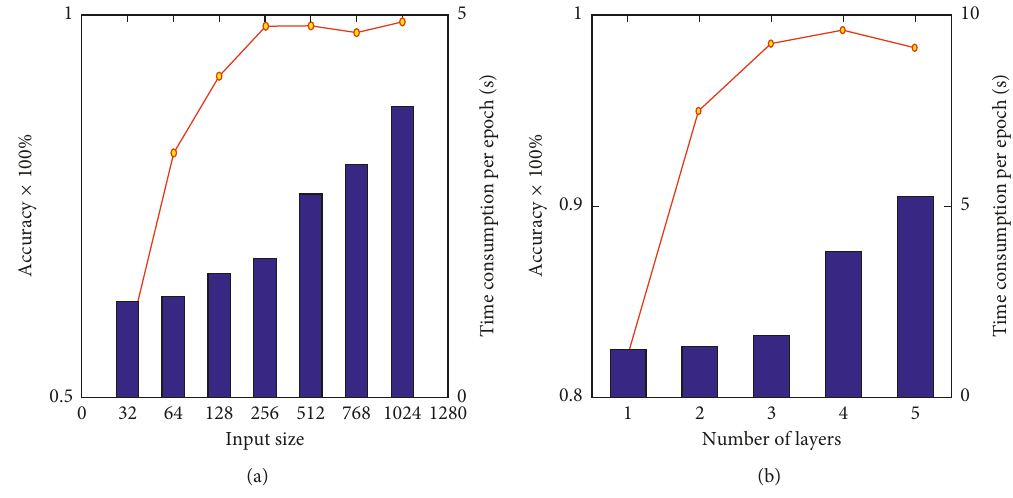
Figure 9: Experimental results of hyperparameters. (a) Input size. (b) Number of LSTM